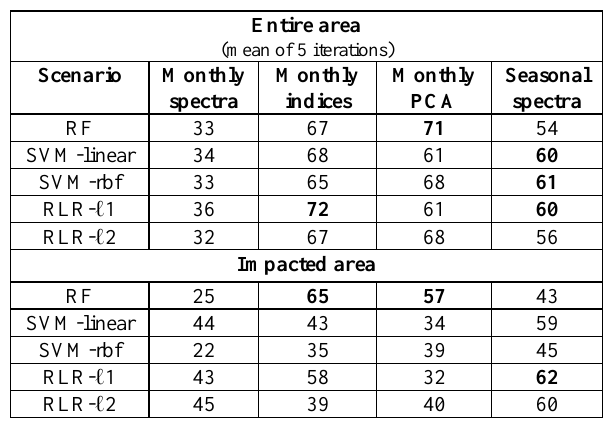
Table 8 . Overall accuracy of different classifiers for different multitemporal MS scenarios. Combination of PSRI, GNDVI, WRDVI and IRECI indices.